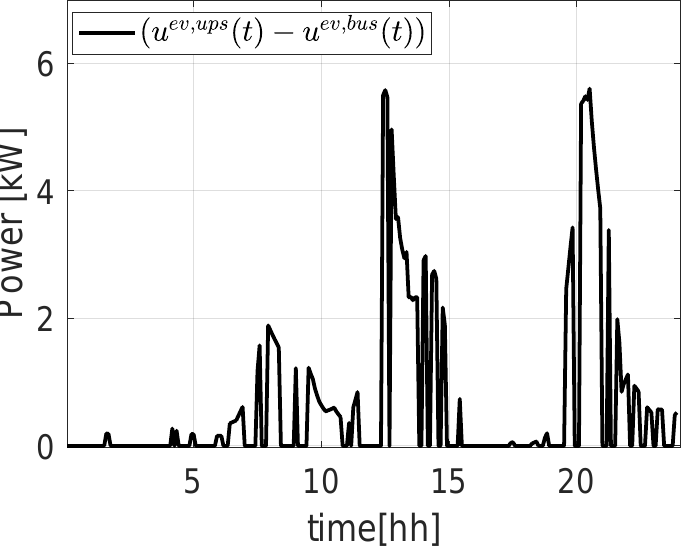
Figure 13. Difference between power provided to PEVs in BUS and UPS